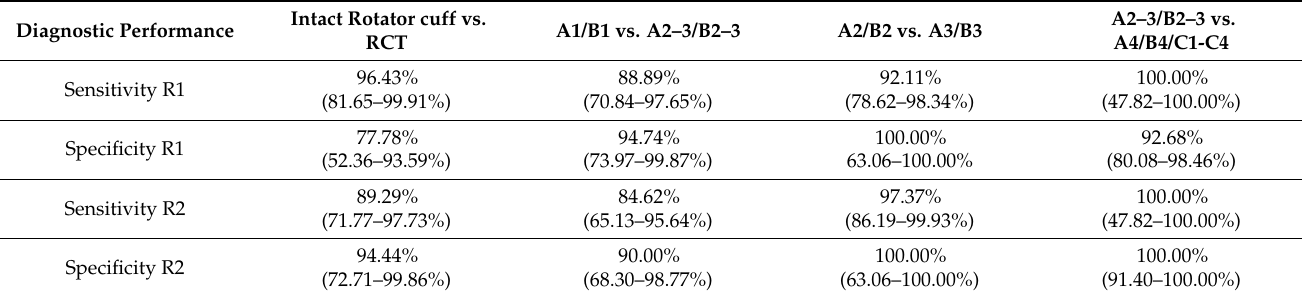
Table 4. US sensitivity and specificity of the two readers (CI 95%) using MRA as the gold standard.